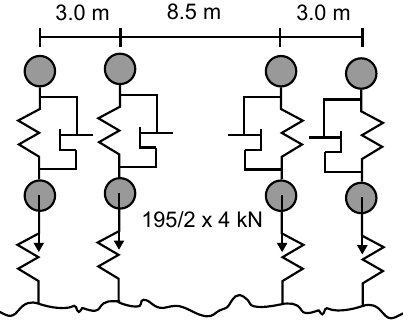
Figure 4. Quarter bogie model: ICE 2